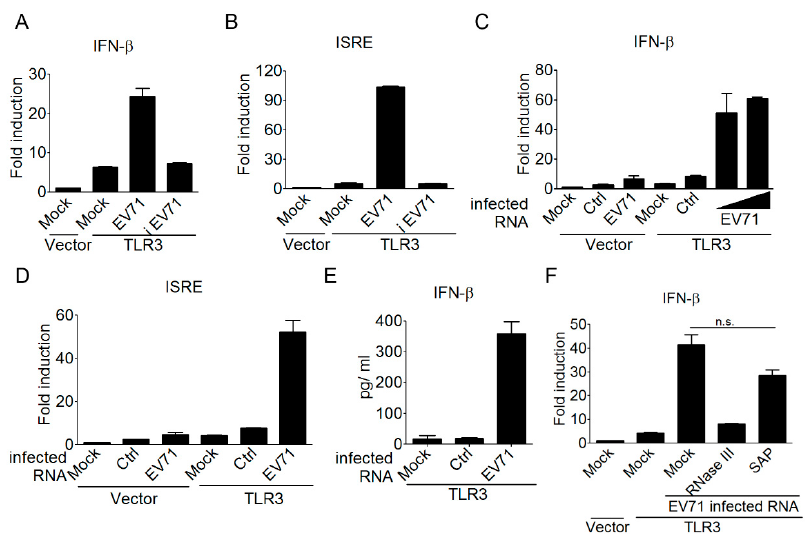
Figure 2. EV-A71-derived, double-stranded RNA is a ligand for TLR3 detection. ( A – D ) HEK293 cells were transfected with either a control vector or Flag-tagged TLR3, plus an IFN- β reporter plasmid ( A , C ) or an ISRE reporter plasmid ( B , D ). After 24 h, the transfected cells were either left untreated or infected with EV-A71 (MOI, 0.1) or heat-inactivated EV-A71 (iEV-A71) (MOI, 0.1). After another 40 h, the treated cells were harvested to analyze the IFN- β or ISRE promoter activity ( A , B ). Control RNA (ctrl, 2 µ g/mL) and EV-A71-infected RNA (two doses, 1 and 2 µ g/mL) harvested from HEK293 cells and EV-A71-infected HEK293 cells, respectively, were used to stimulate the transfected cells by DOTAP activity ( C , D ). ( E ) HEK293 cells were transfected with Flag-tagged TLR3. Control RNA (1 µ g/mL)